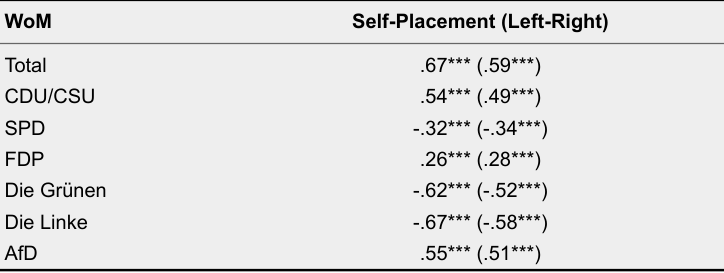
Zero-Order Correlations of WoM and Self-Placement Self-Placement (Left-Right)WoM